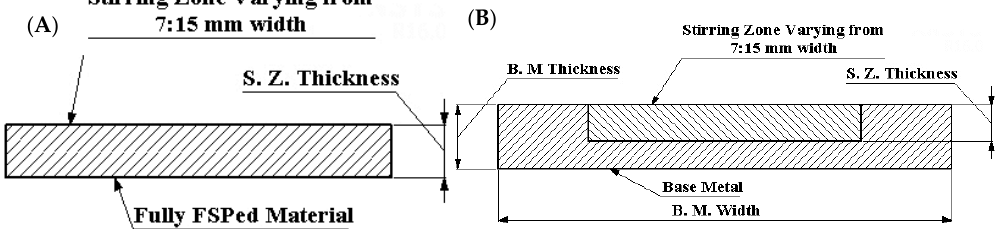
Figure 3. Two different modeled geometries: ( A ) homogeneous rectangle beam; ( B ) cross section in the surface composite rectangle beam.